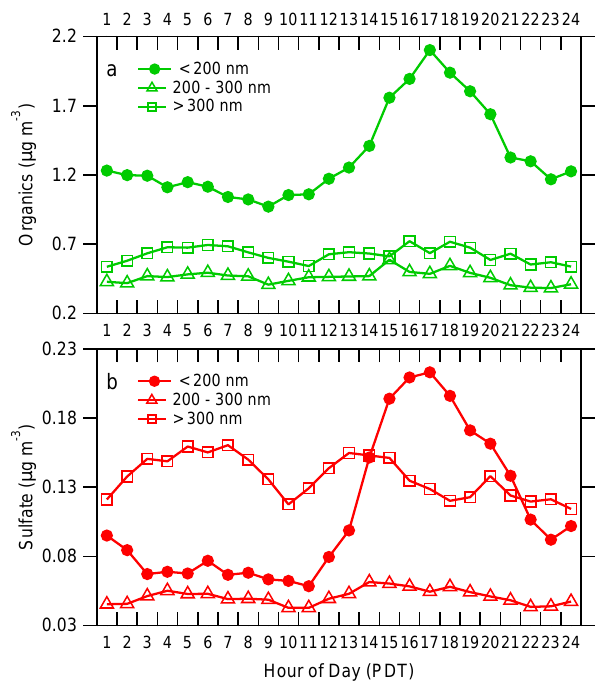
Fig. 9. Diurnal patterns of organics (a) and sulfate (b) in the size range 35–200nm, 200-300nm and 300–1000nm (in D va ). Data correspond to the